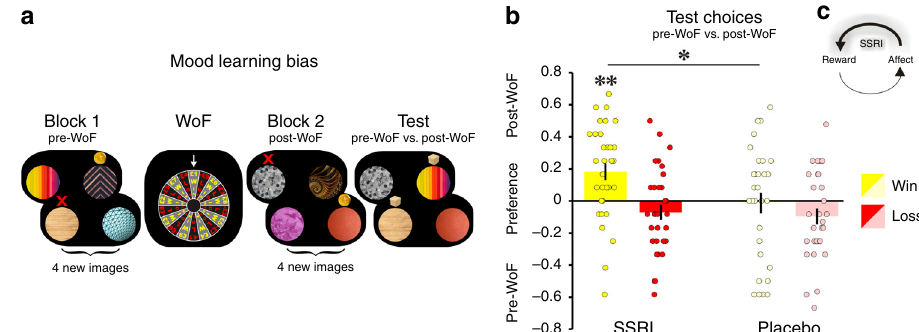
performance decreased more for 3-day (II to III and III to IV) as